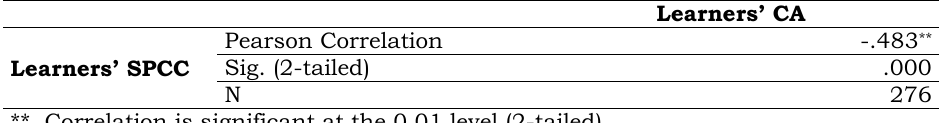
Table 3: Correlation between learners’ SPCC and their CA